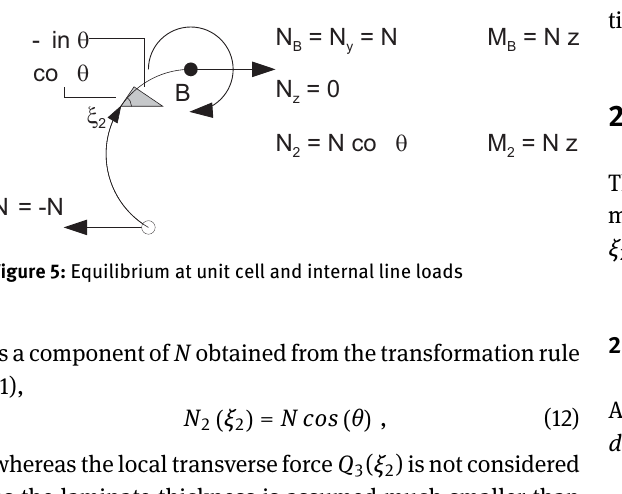
whereas the local transverse force Q as the laminate thickness is assumed much smaller than the corrugation-shape curvature. We connect the local